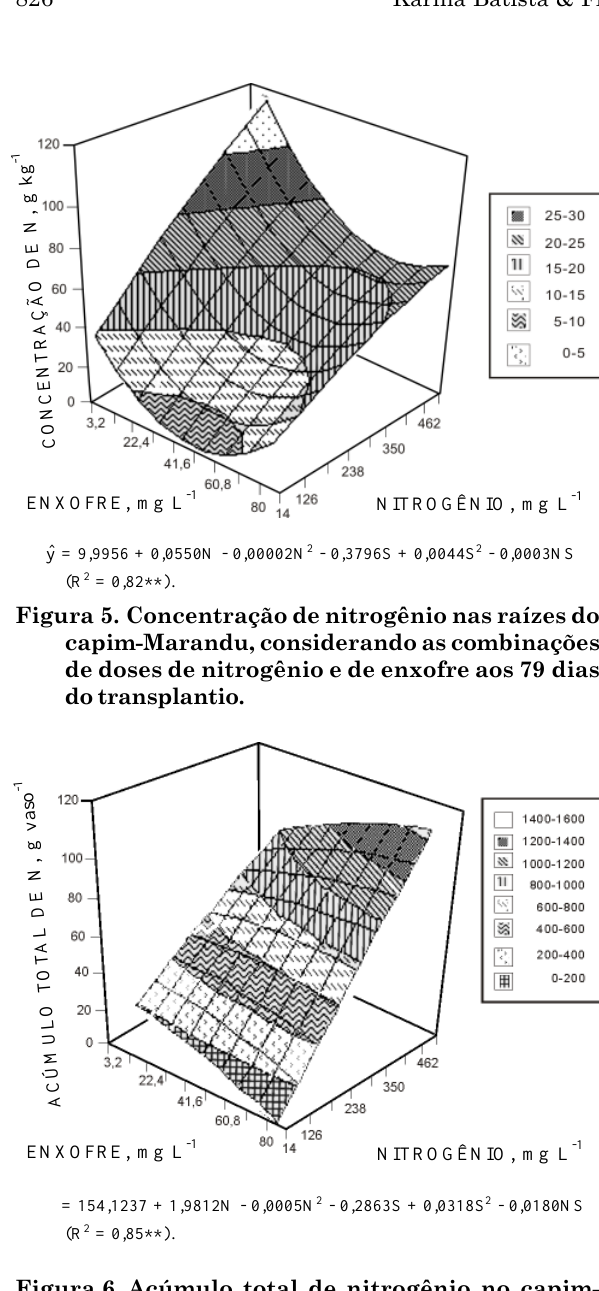
Figura 6. Acúmulo total de nitrogênio no capim- Marandu, considerando as combinações de doses de nitrogênio e de enxofre aos 79 dias do